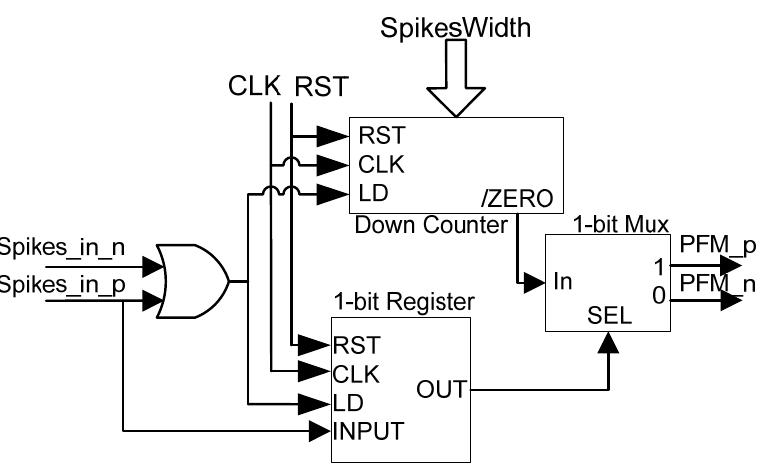
Figure 4. Spikes Expansor internal